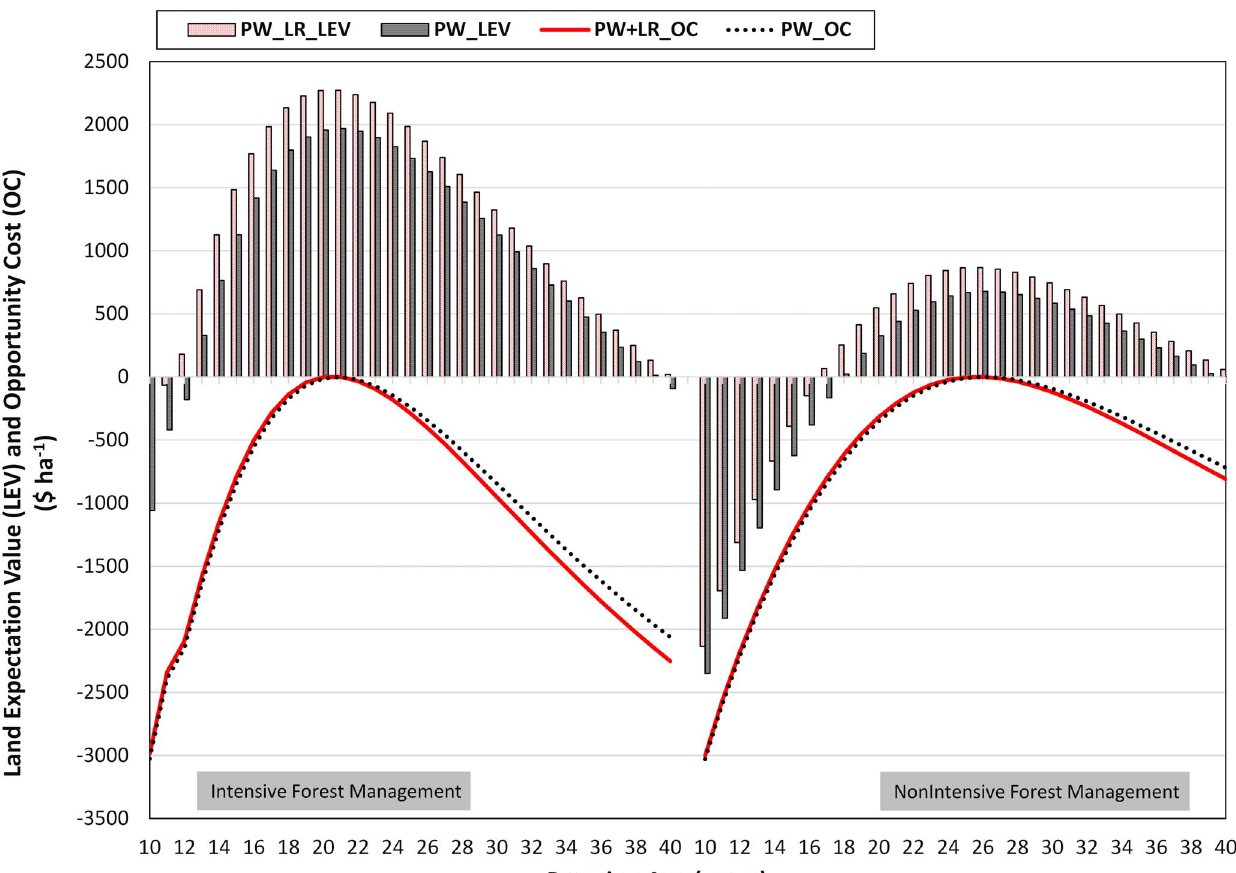
Figure 2. Distribution of land expectation values (LEVs) and opportunity costs (OCs). Opportunity cost is calculated by subtracting land expectation value at a given harvest age from the land expectation value at the optimal rotation age. The land expectation value is highest at the optimal rotation age.